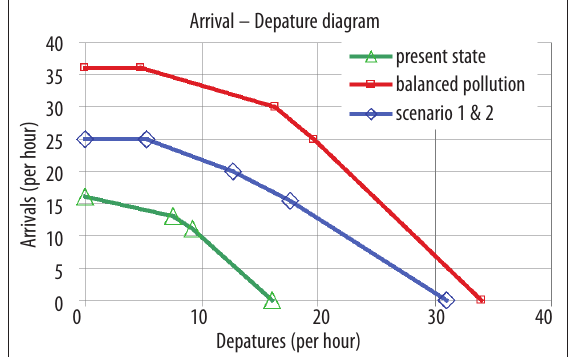
Fig. 15. Potential future development at Nikola Tesla Airport